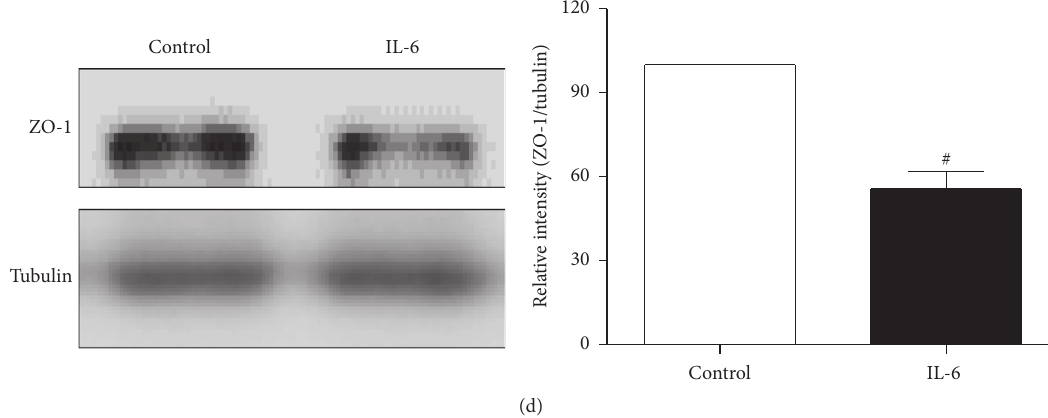
Figure 3: Effects of KIOM-MA/MA128 on Caco2 monolayer intestinal barrier function. (a) Intestinal barrier function was analyzed via the TER value, and paracellular permeability was determined using a nonabsorbable, fluorescein isothiocyanate- (FITC-) conjugated dextran probe (FD-30). Caco2 monolayer cells were pretreated with 400 𝜇 g/ml KIOM-MA/MA128 1h prior to IL-6 (10ng/ml and 50ng/ml) exposure for24h.(b)Caco2monolayercellswerepretreatedwith400 𝜇 g/mlKIOM-MA/MA1281hpriortoIL-6(50ng/ml)exposurefor24 h.ZO-1was detected via immunofluorescence microscopy. Treatment of IL-6 caused significant disruptions of ZO-1. The ZO-1 staining was decreased in intensity and exhibited an irregular band. Four hundred 𝜇 g/ml KIOM-MA128 completely prevented ZO-1 in IL-6 treated Caco2 monolayers. (c) Histograms are represented by continuous bands encircling the cells at the cellular borders. (d) Cell lysates were analyzed for ZO-1 expression via Western blot. The results are reported as the means ± SDs from 3 independent experiments. ∗ 𝑝 < 0.05 compared with the IL-6 treated group; # 𝑝 < 0.05 compared with the control